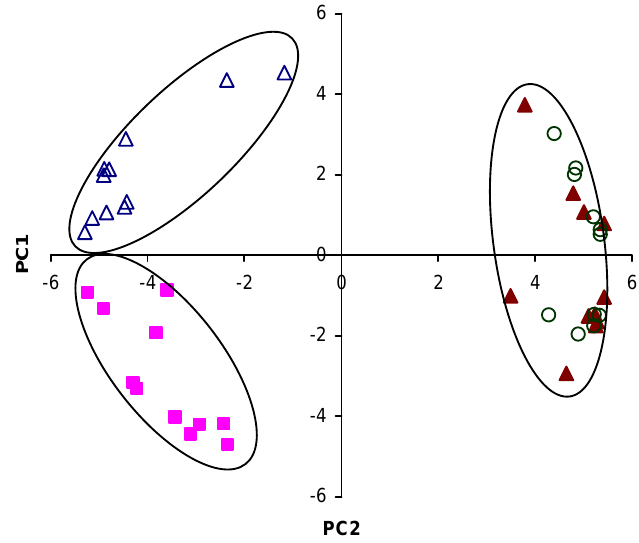
Figure 9. Identification of benzene ( ■ ), toluene ( ∆ ), ethylbenzene ( ▲ ), xylene ( ο ) using